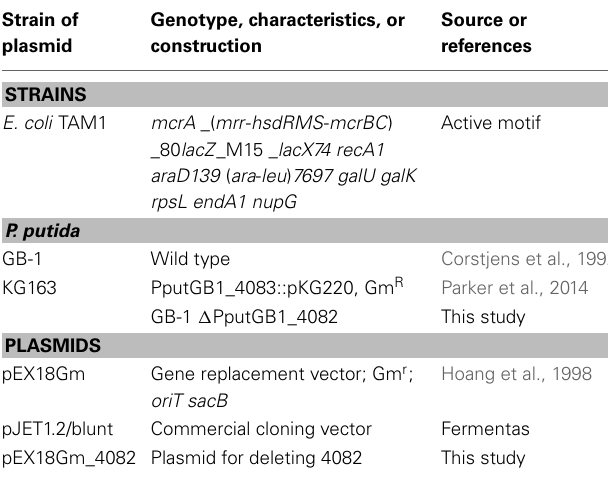
Table 2 | Primers used for in-frame deletion of putative ferri-PVD receptor, PputGB1_4082.